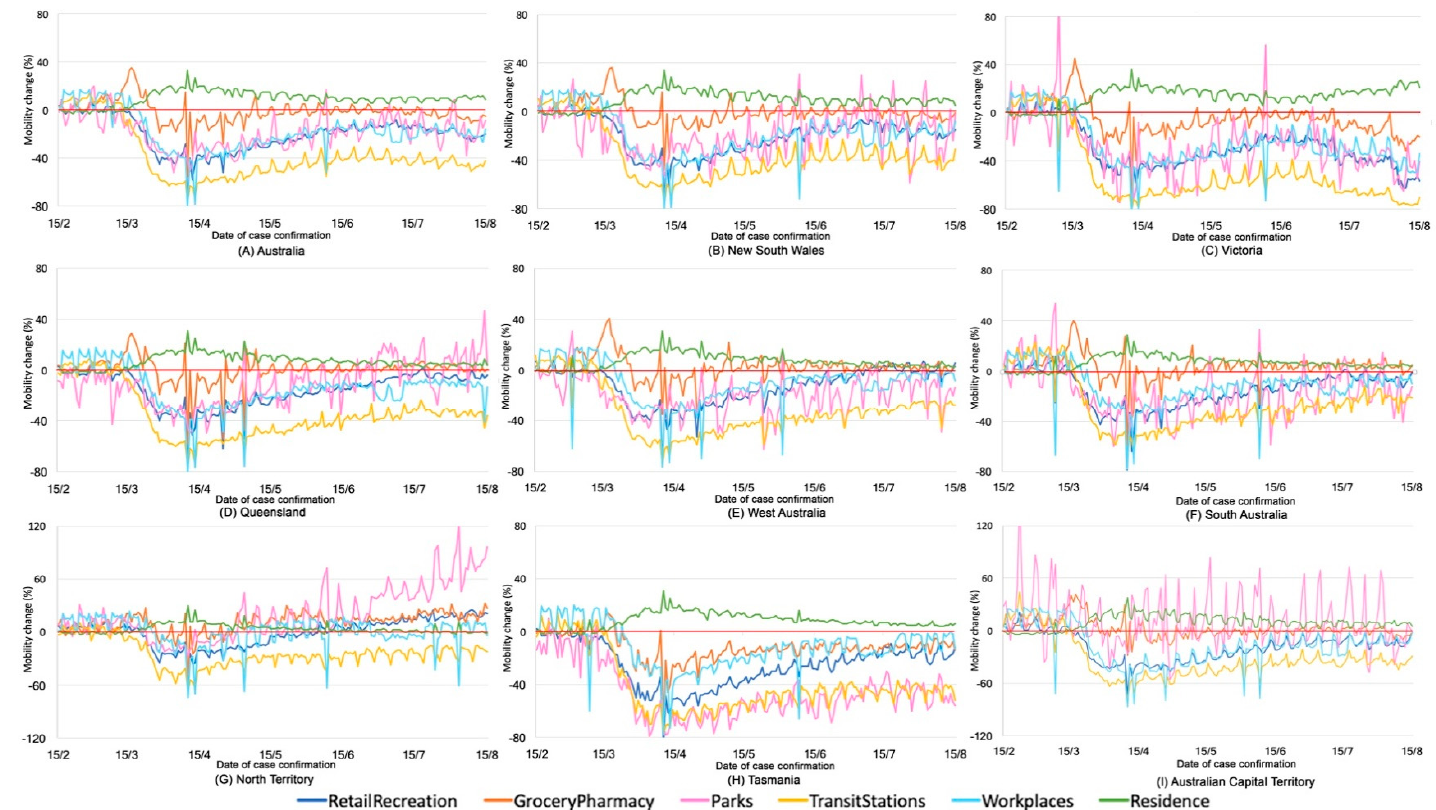
Figure 3. Six types of mobility in each Australian state/territory.